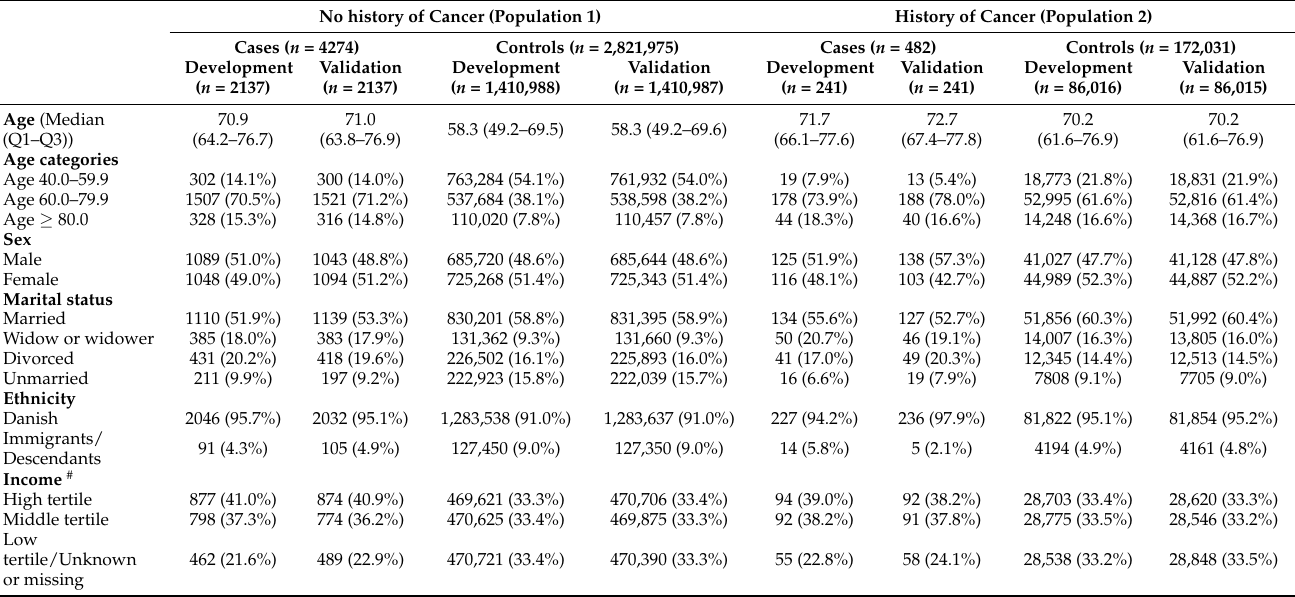
Table 1. Characteristics of the study populations stratified by development and validation